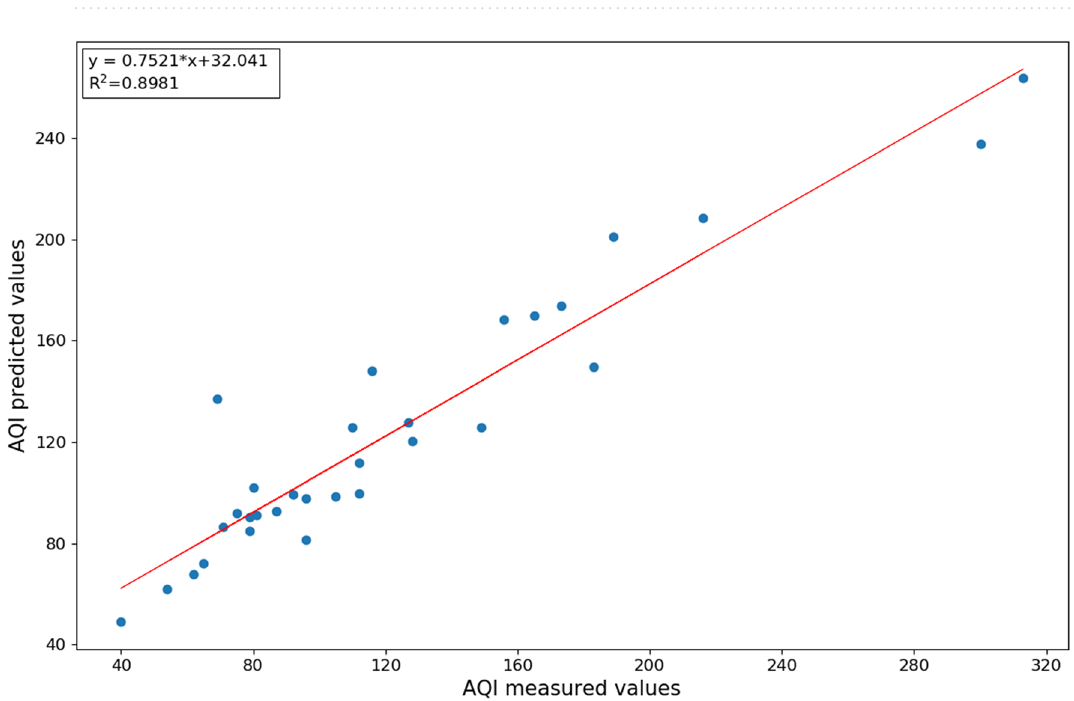
Figure 7. Linear fitting of predicted and measured AQI